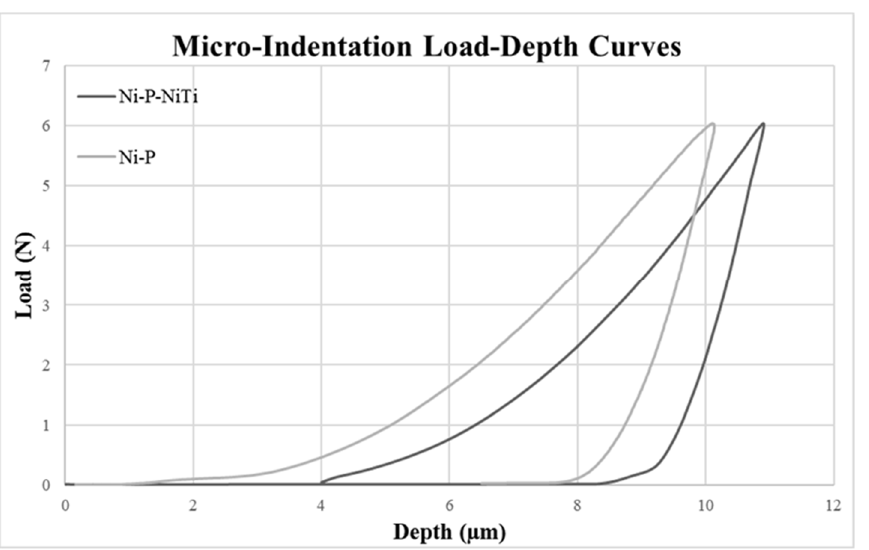
Figure 3. Micro-Indentation Load-Depth Curve Examples.